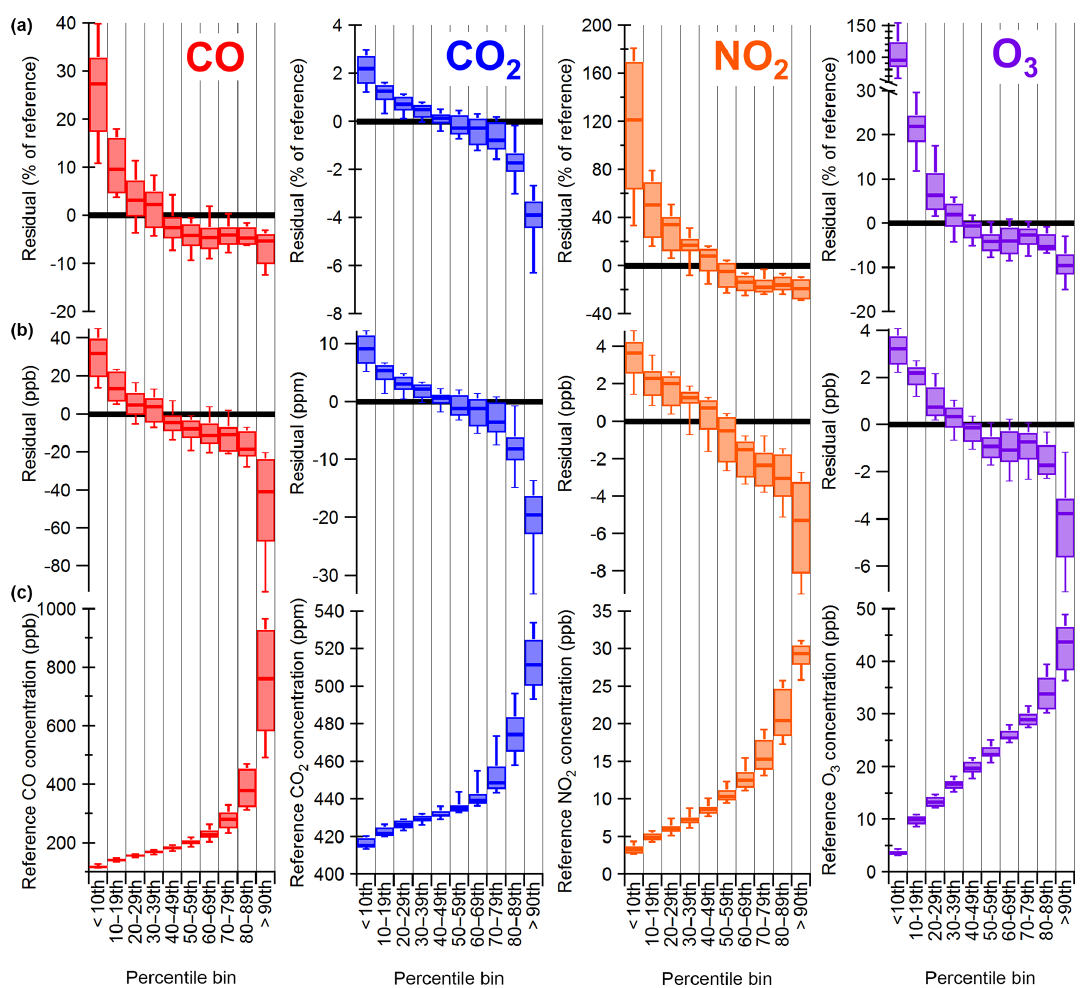
Figure 10. Box plots from the 10–16 RAMP monitors of median concentrations measured by monitors ( c ) and median model residuals ( b ) and model residuals normalized to the reference concentration ( a ) for each pollutant, divided into deciles. The box plots provide the range of medians by the different RAMP